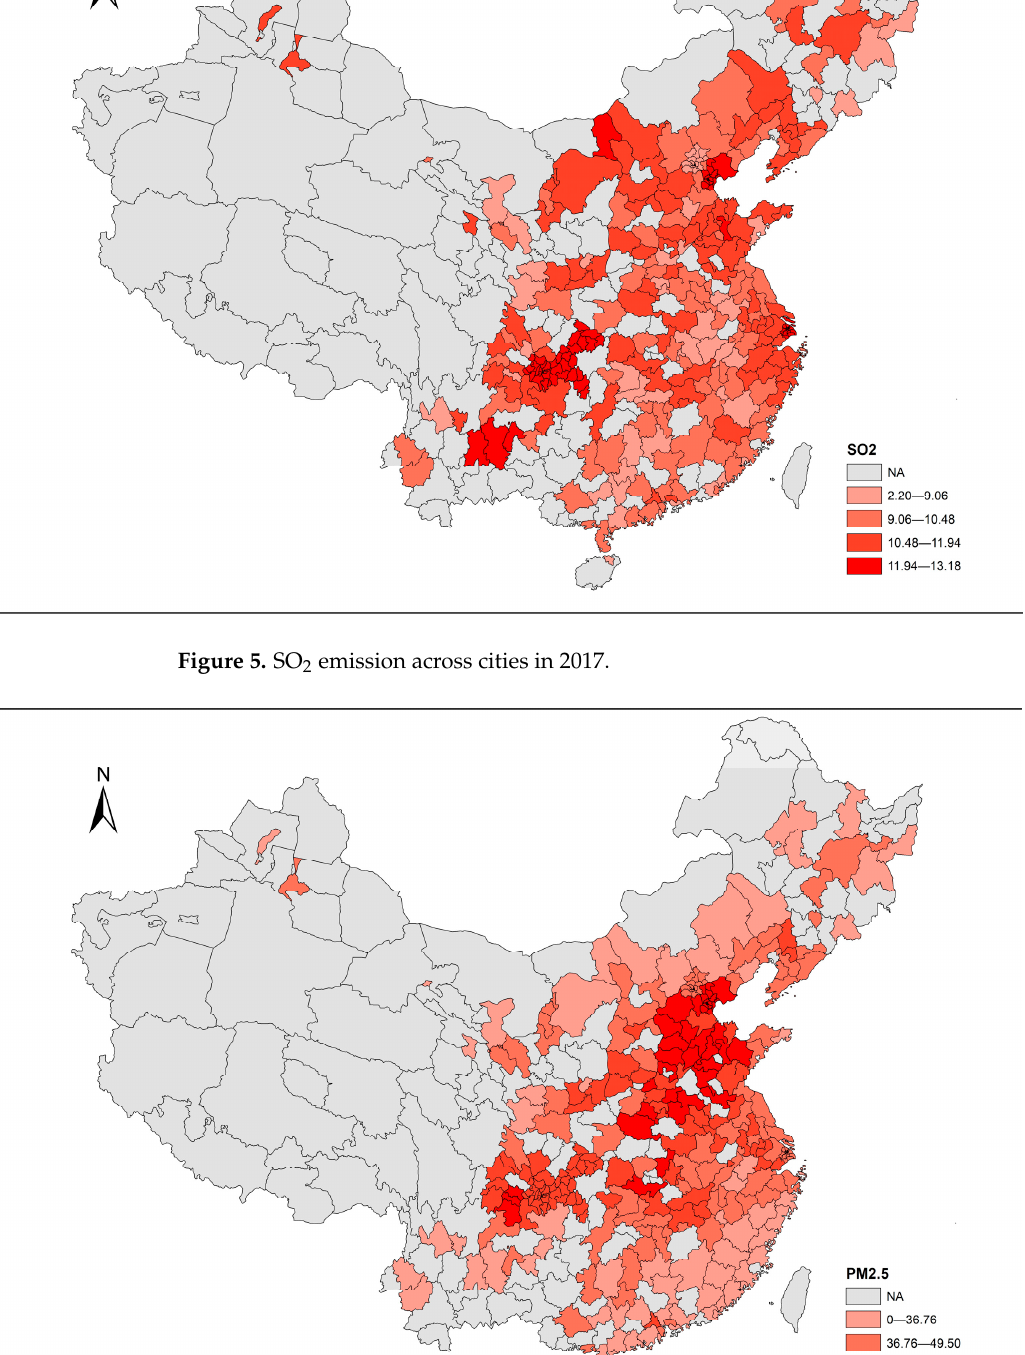
Figure 6. PM emission across cities in 2017. (cid:2870).(cid:2873)